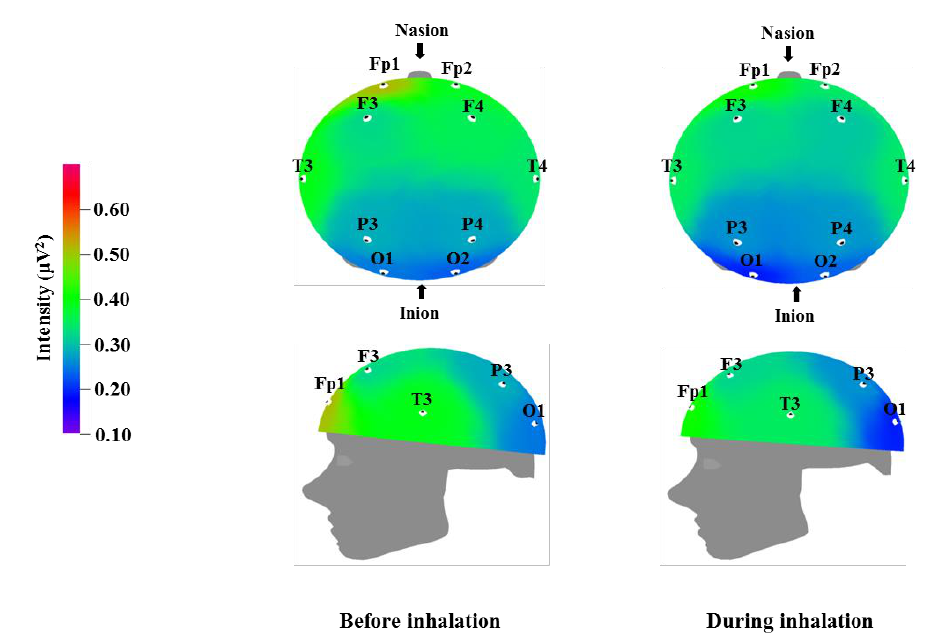
Figure 1. Relative theta wave intensity between before and during inhalation of VOCs from C. indicum Linné.